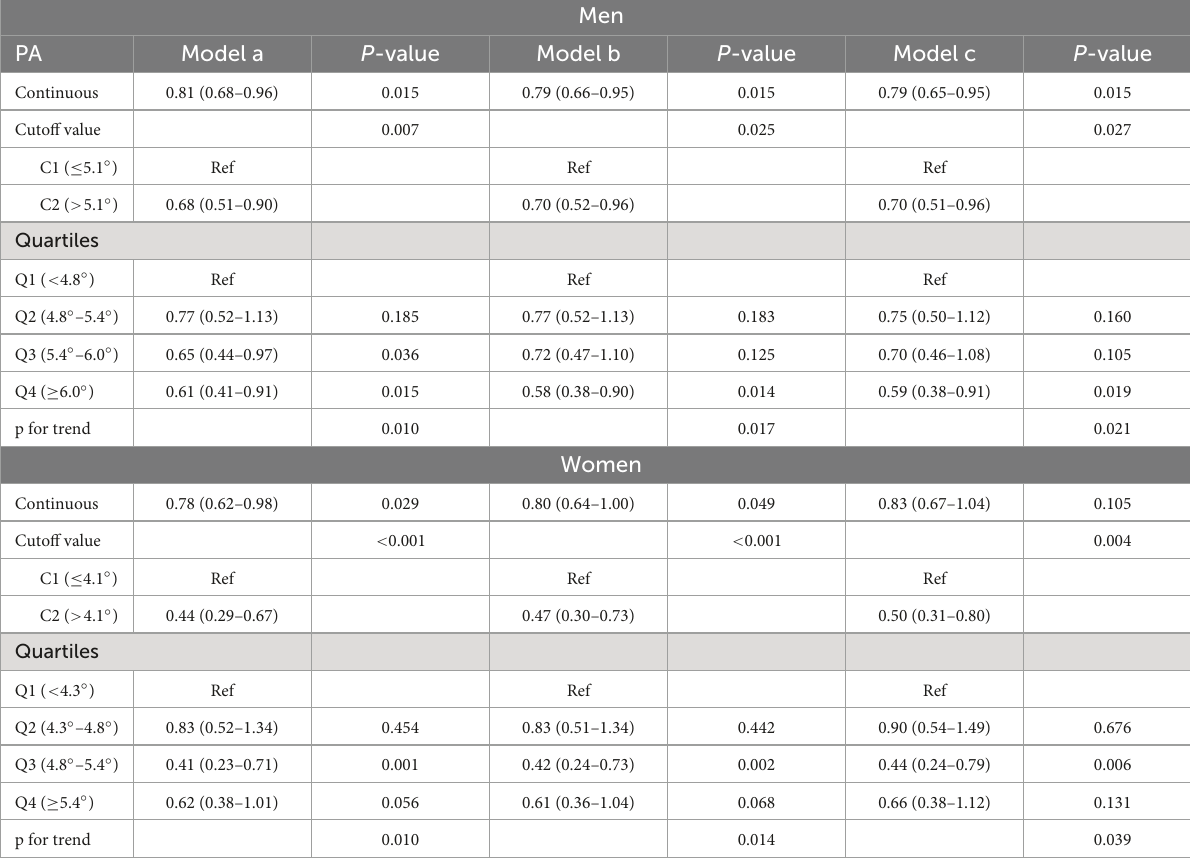
TABLE 1 Cox regression analyses for the associations between phase angle (PA) and all-cause mortality in patients with lung cancer.